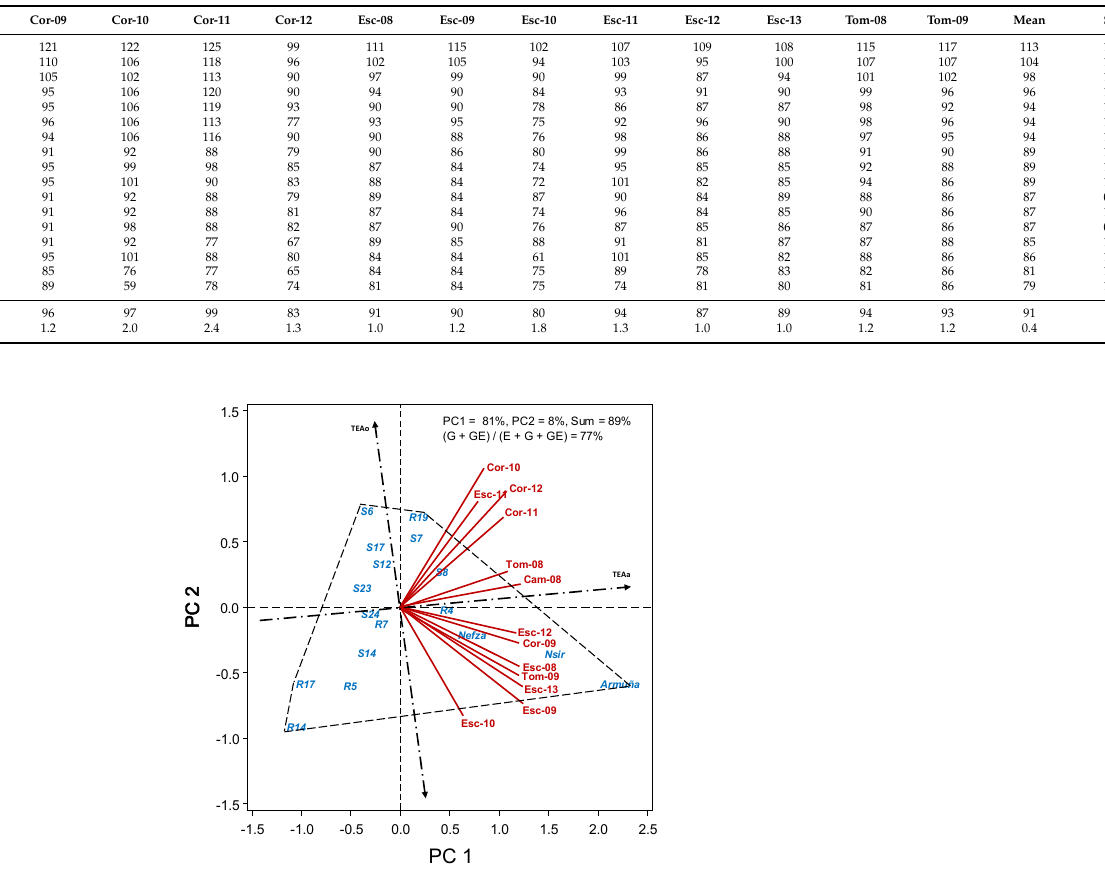
Figure 2. HA-GGE biplot based on days to flowering (dtf) of 17 lentil accessions grown at 10 field–year environments, from 2009 to 2013.